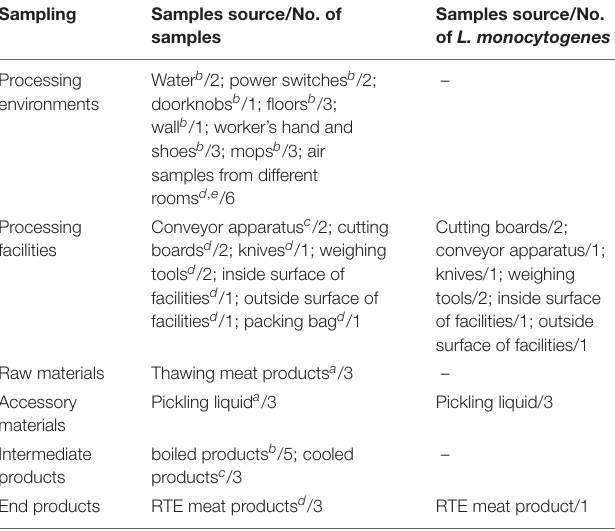
TABLE 1 | Sampling locations in an RTE processing plant and detection of L. monocytogenes